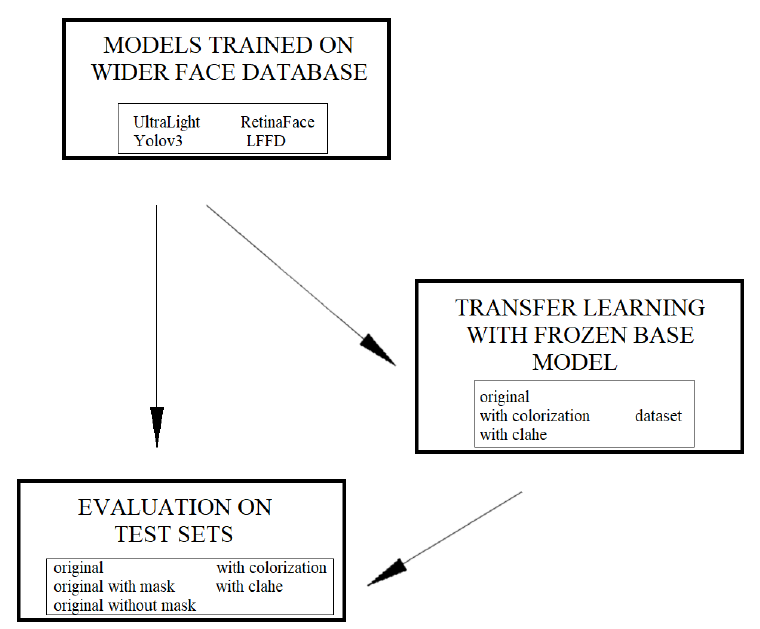
Figure 3. The framework model of the testing scenario.